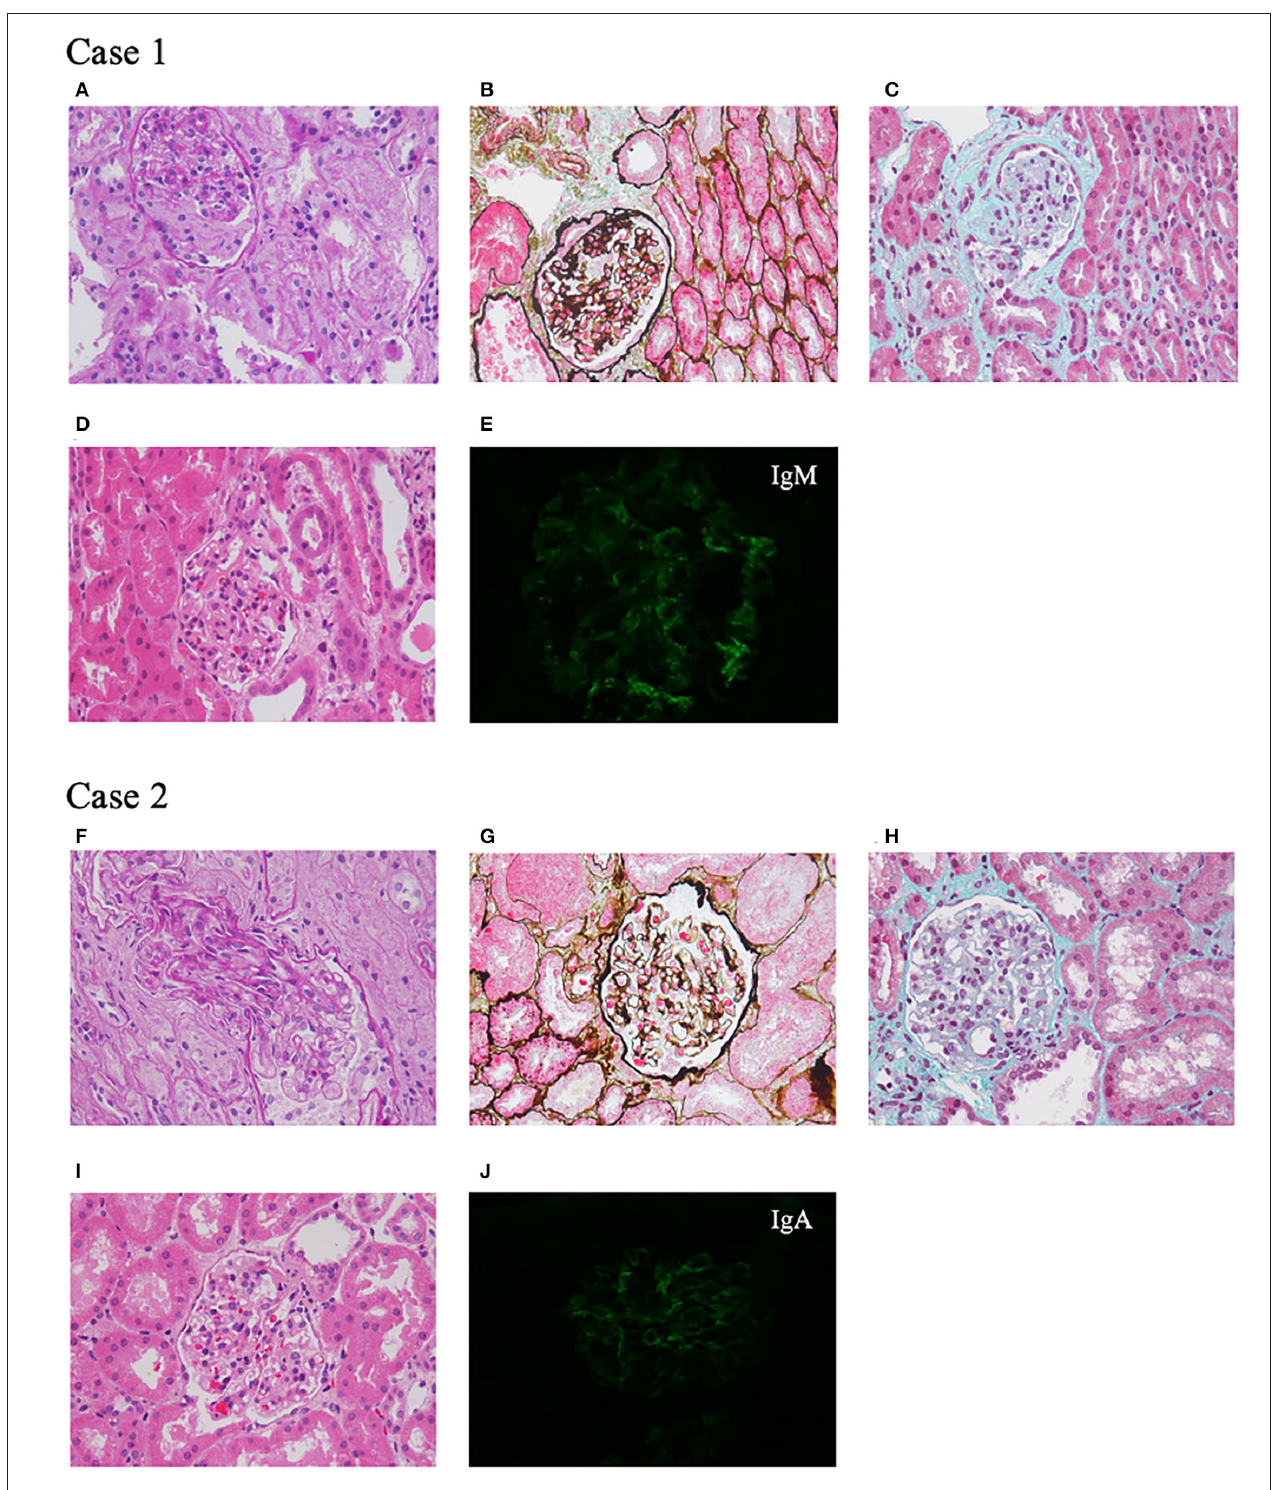
FIGURE 1 | Renal pathological presentation of two probands. (A–D,F–I) Light microscopy. (A,F) Periodic Acid Schiff staining, × 400 magnification. (B,G) Periodic acid-silver methenamine staining, × 400 magnification. (C,H) Masson staining, × 400 magnification. (D,I) Hematoxylin-eosin staining, × 400 magnification. (E,J)